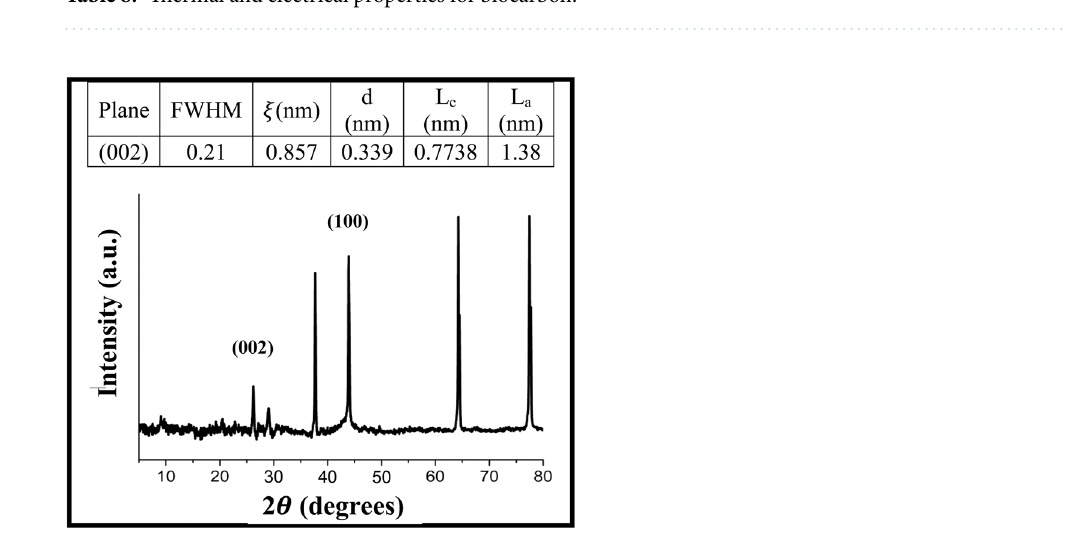
Table 8. Thermal and electrical properties for biocarbon.